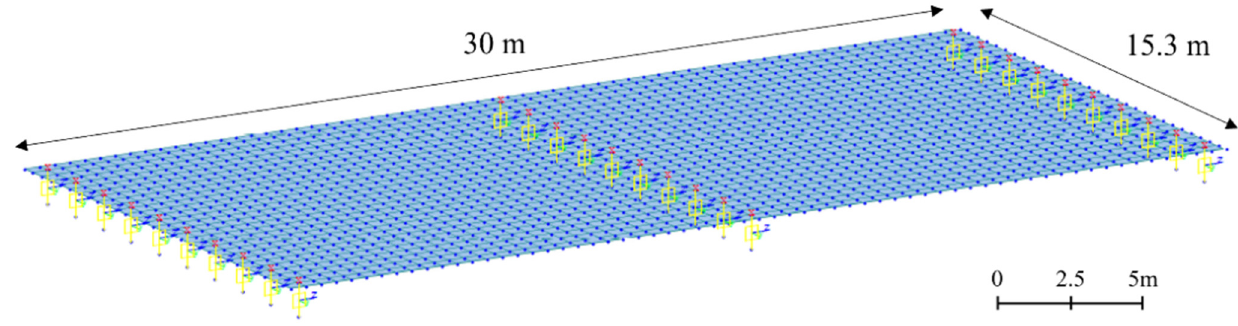
Figure 9. RC-slab-bridge modeling.